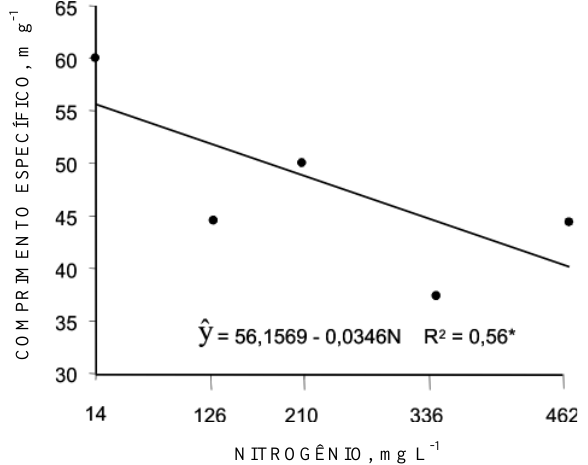
Figura 4. Comprimento específico do sistema radicular do capim-Marandu, considerando as doses de nitrogênio aos 79 dias do